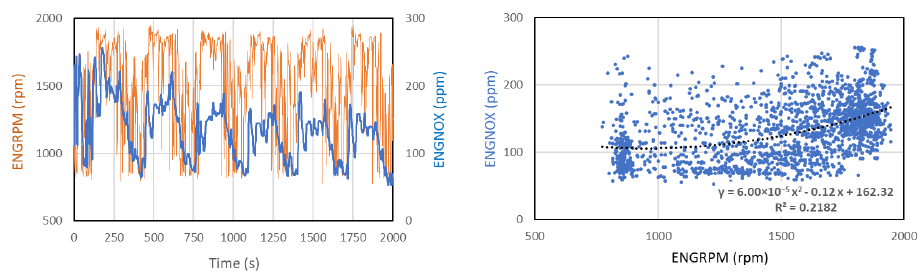
Figure 4. Relation of NOx emission (ENGNOX) with engine rotation speed (ENGRPM) over several working cycles with corresponding second-order polynomial regression.